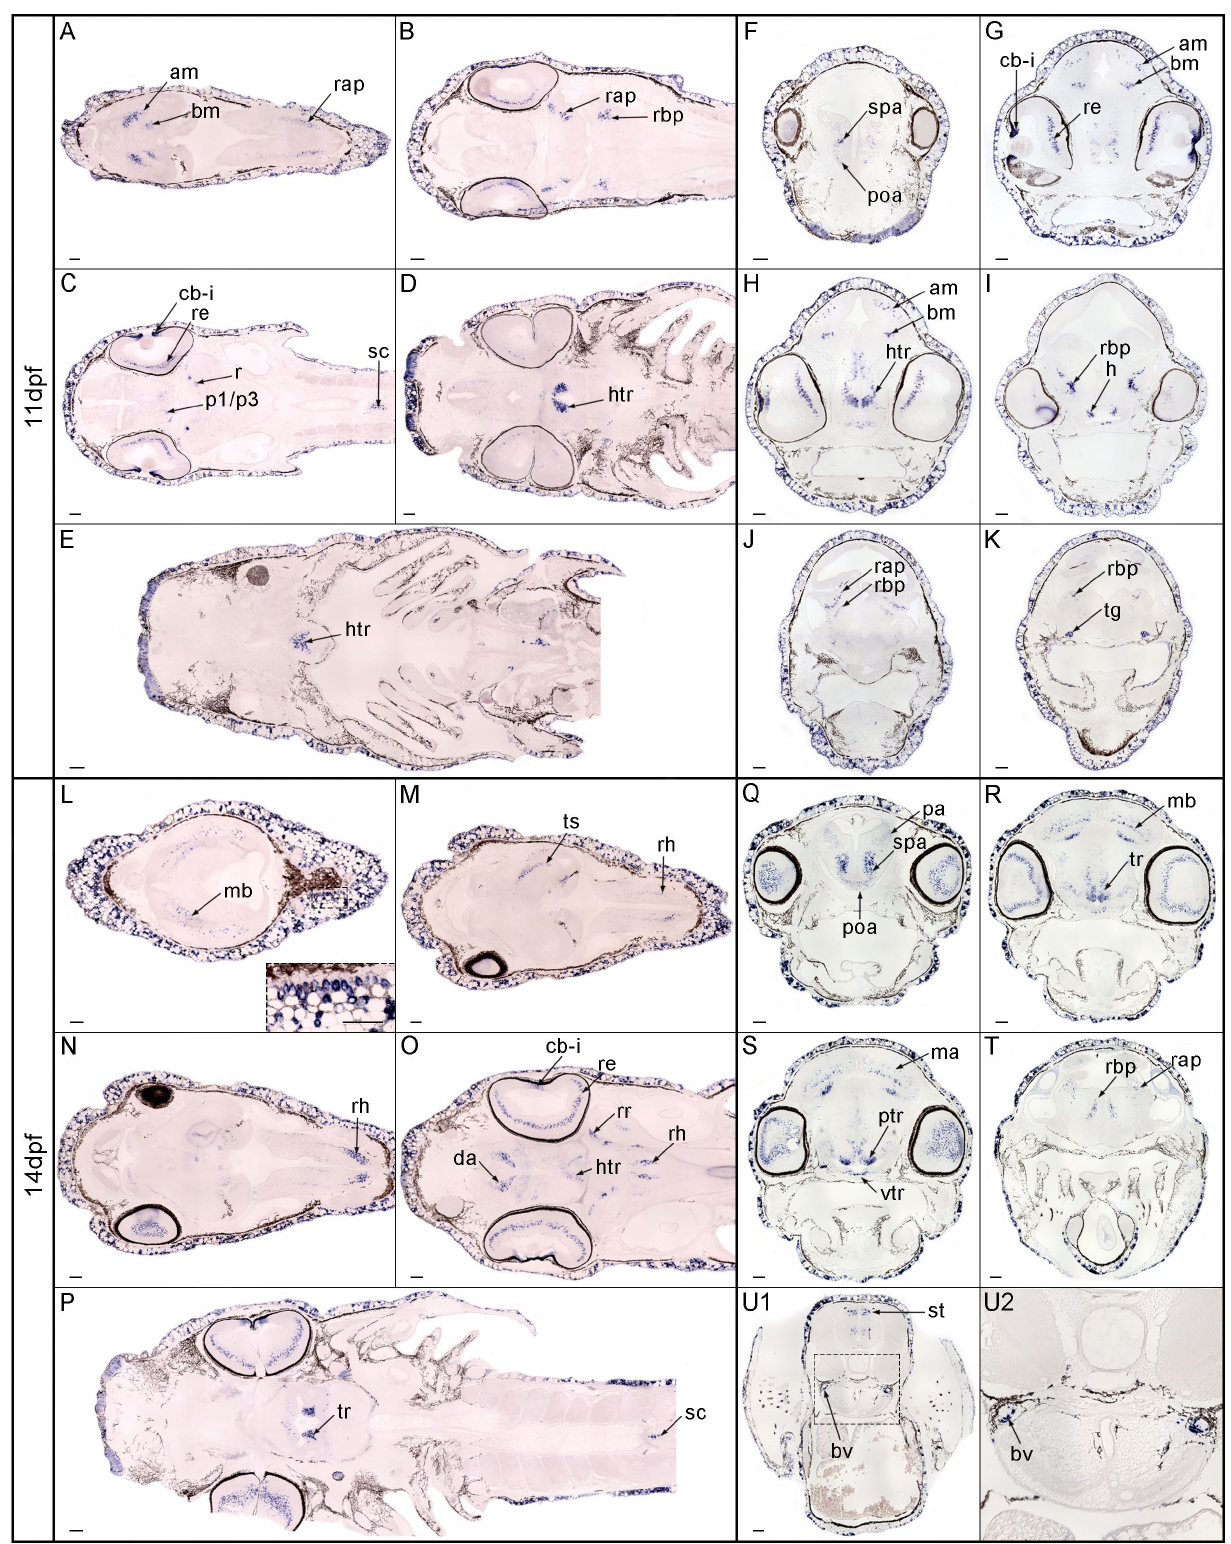
Figure 4. Expression patterns of nos1 in spotted gar larvae (11–14 dpf). At 11 dpf, nos1 was expressed in the mesencephalon ( A ), rhombencephalon ( A , B ), and eye, spinal cord, rhombencephalon and basal plate of the diencephalic region ( C ). Positive cells were localized in the rhombencephalon ( D , I –